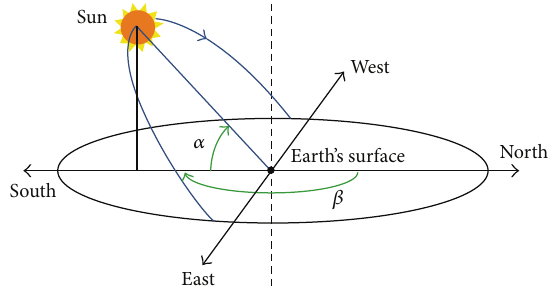
Figure 1: Illustration of the solar angles: (a) altitude angle, 𝛼 ; (b) azimuthal angle, 𝛽 . The solar path corresponds to a day in the early fall or late winter seasons in the northern hemisphere, that is, just prior to the spring equinox or just after the fall equinox. Solar noon is the time of day when 𝛽 = 180 degree, that is, the sun is directly at south and is halfway between sunrise and